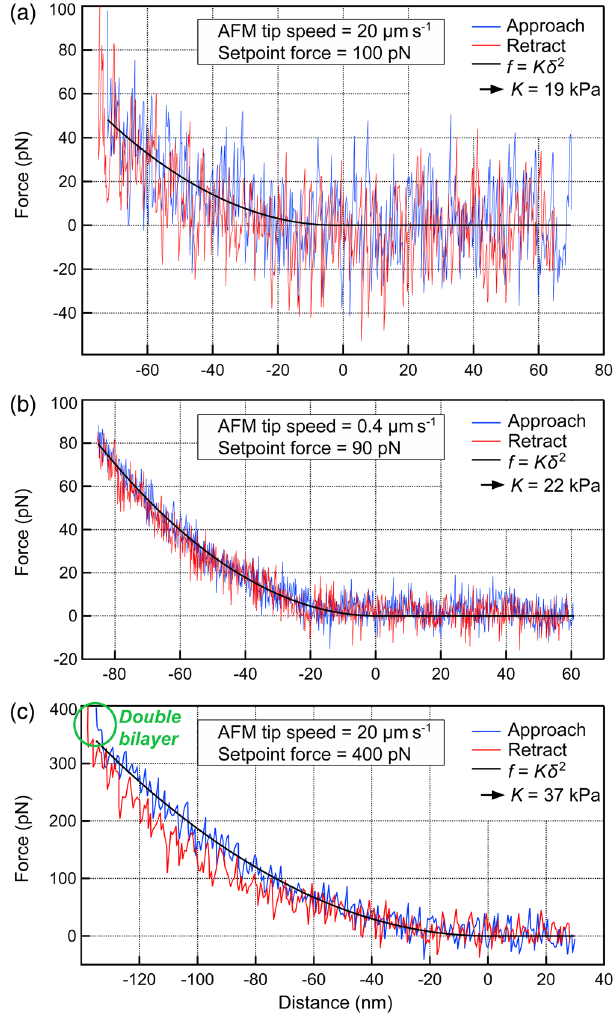
FIG. 3. High resilience of SMC nanotubes. (a) Force-distance curves collected at a speed of 20 μ m = s and (b) at a speed of 0 . 4 μ m = s on the same nanotube. Note that in both graphs K are similar, although the amount of thermal noise is clearly higher at higher speed. (c) Force-distance curves collected on another nanotube (height 130 (cid:2) 10 nm) with a high setpoint force of 400 pN. At such high force, the nanotube is fully compressed (i.e., maximum indentation depth similar to nanotube height) and the indenter pushes on a double bilayer, as indicated by the sudden increase in force when indentation depth reaches ∼ 130 nm (circle). N.B., in all graphs, the approach and retract curves overlap, at least for forces under 100 pN (i.e., maximum setpoint force typically used for imaging), indicating no hyste- resis and thence purely elastic behavior. Furthermore, as the tip retracts from the nanotube, the nanotube does not maintain contact with the tip, indicating the absence of (detectable) nonspecific adhesion between the tip and the